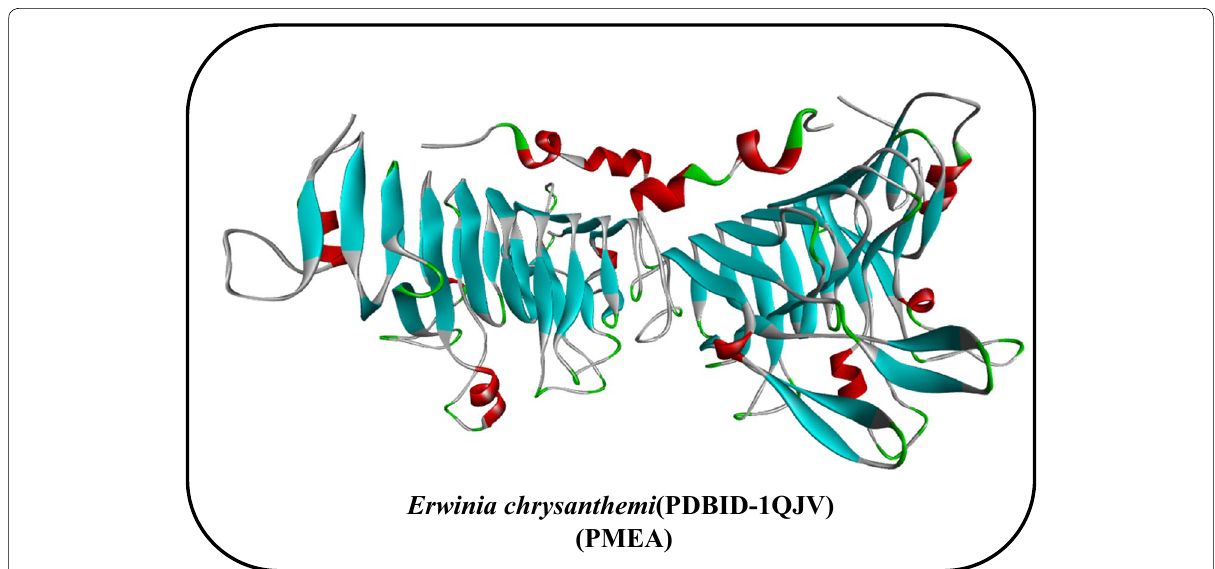
Fig. 2 The protein secondary structure of Erwinia chrysanthemi pectin methyl esterase (carbohydrate esterase class-8) (PDB ID:1QJV) (Jenkins et al. 2001), where alpha-helices (red), beta strands (blue) and coils (gray). (Image was developed using Discovery Studio Visualizer ®